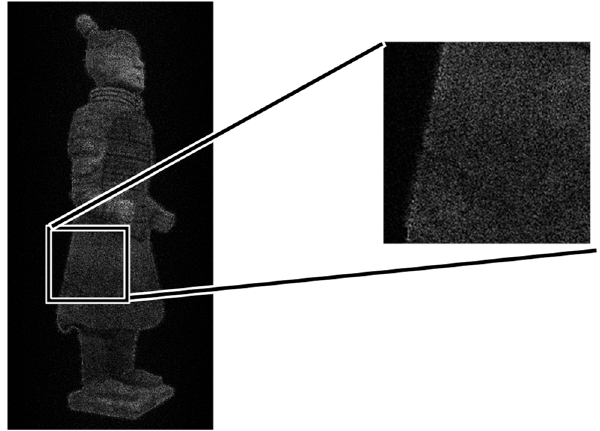
Figure 8. Layering Terra-Cotta Warrior model, thickness of layering set at 1 mm.